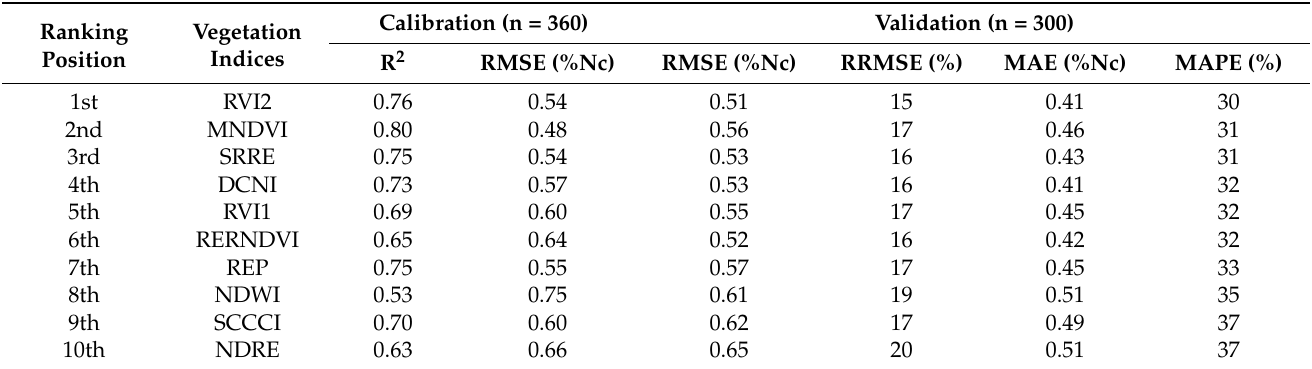
RMSE: root-mean-square error of the error. RRMSE: RMSE relative to the observed mean. MAE: the mean absolute error. MAPE: the mean absolute percent error. The description of the acronyms of the vegetation indices is in Table S1 of the supplementary material.